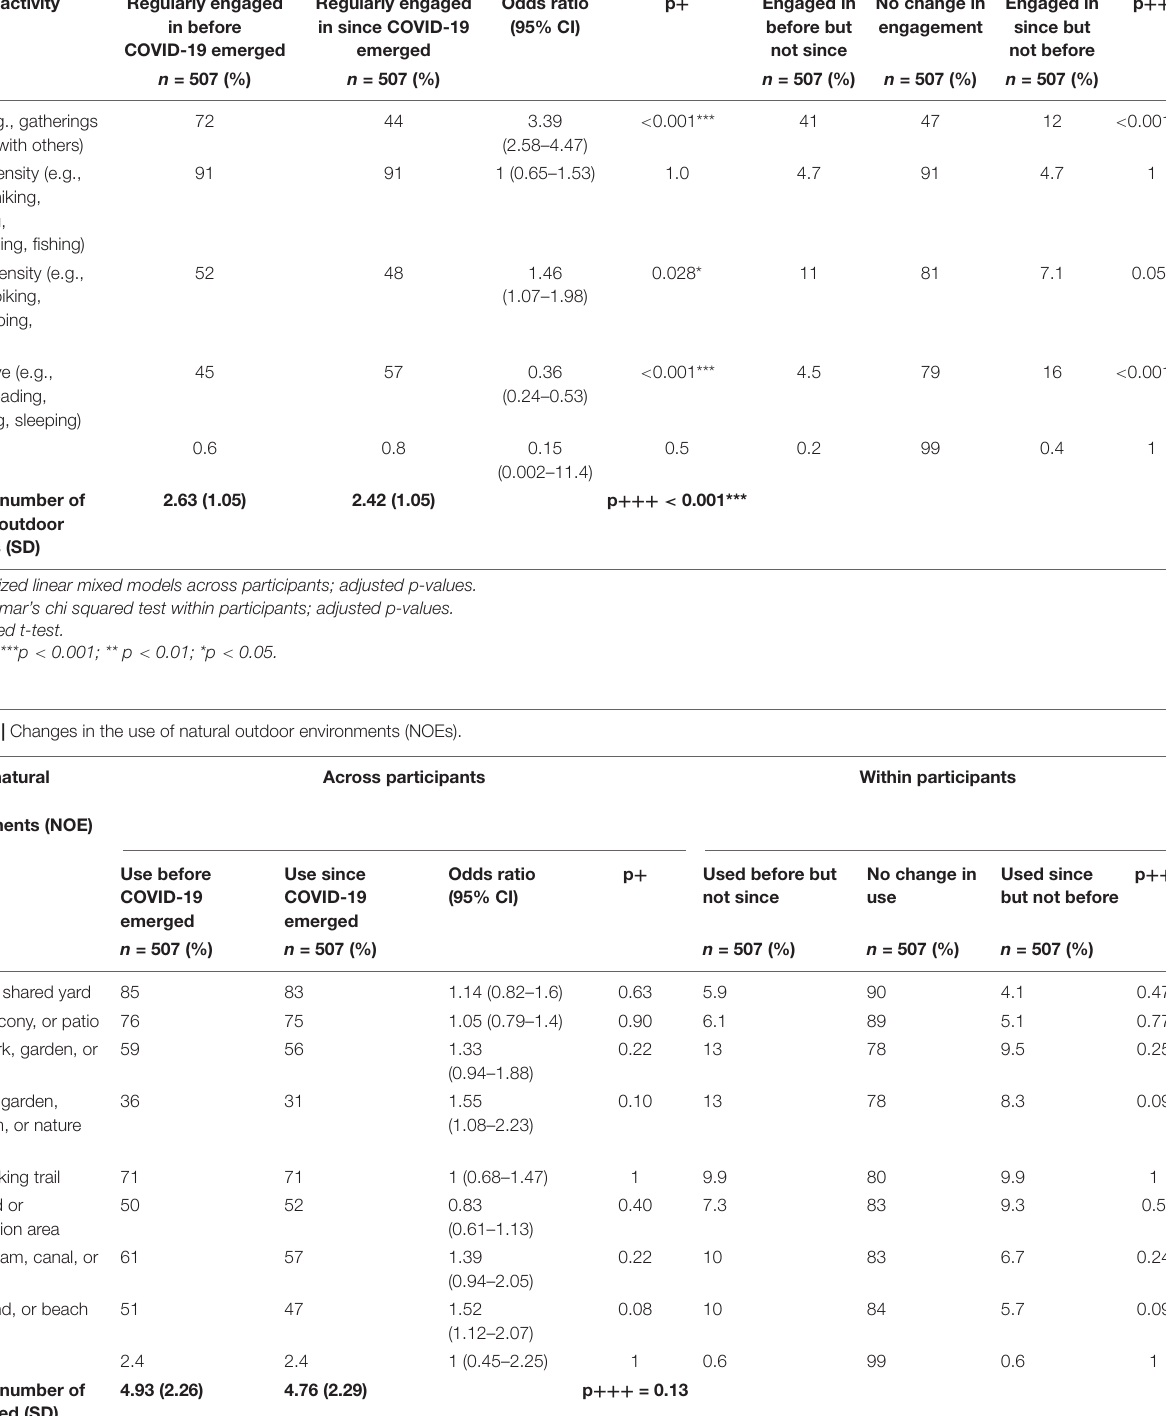
Across participants